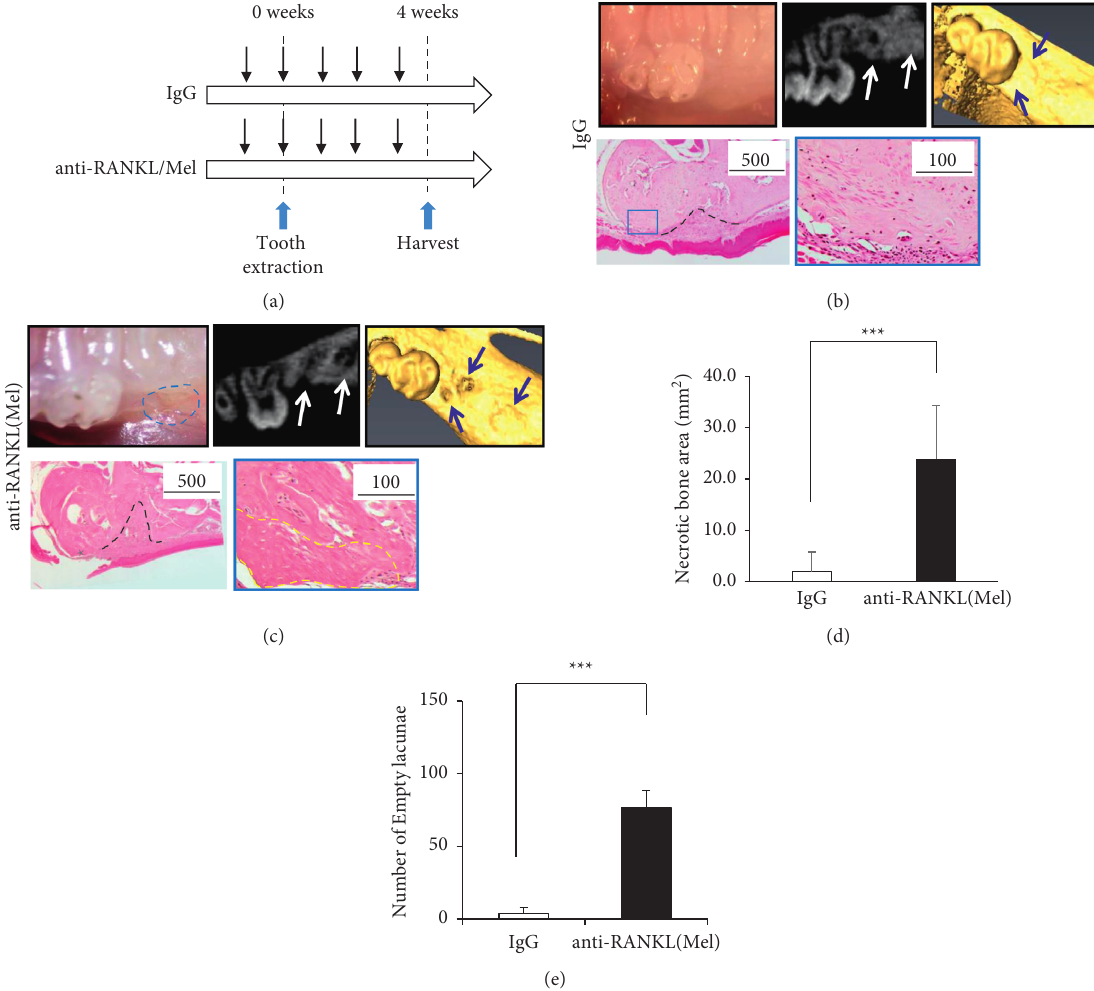
Figure 1: Development of a mouse model of DRONJ-like lesions. (a) The schematic timeline protocol for a mouse model of DRONJ-like lesions. (b) The upper left panels show the representative gross appearance of gingival mucosa at the extraction site of IgG. The upper middle panel shows μ CTscans of the extraction site. White arrows indicate extraction sockets of the root with new bone formation. The upper right panel shows a 3D image of the extraction site. Blue arrows indicate extraction sites filled with new bone formation. The lower left panel shows H&E staining of a low magnification image at the extraction site. A black dotted line surrounds the outline of the extraction socket of the root. Bar is 500 μ m. The lower right panel shows H&E staining of a high magnification image of the blue box in the lower left panel. Bar is 100 μ m. (c) The upper left panels show the representative gross appearance of gingival mucosa at the extraction site of anti-RANKL/Mel. The blue dotted line indicates the open socket of the extraction site. The upper middle panel shows μ CTscans of the extraction site. White arrows indicate extraction sockets of the root without new bone formation. The upper right panel shows a 3D image of the extraction site. Blue arrows indicate extraction sockets of the root without new bone formation. The lower left panel shows H&E staining of a low magnification image at the extraction site. A red asterisk indicates an open socket with an area of exposed bone and no mucosal coverage at the extraction site. A black dotted line indicates the outline of the extraction socket of the root. Bar is 500 μ m. The lower right panel shows H&E staining of a high magnification image of the blue box in the lower left panel. A yellow dotted line indicates a necrotic bone area with an empty lacuna. Bar is 100 μ m. (d) Necrotic bone areas in IgG vs. anti-RANKL/Mel. E: number of empty lacunae in IgG vs. anti-RANKL/Mel. Graphs show mean ± SEM. ∗∗∗ p < 0 .